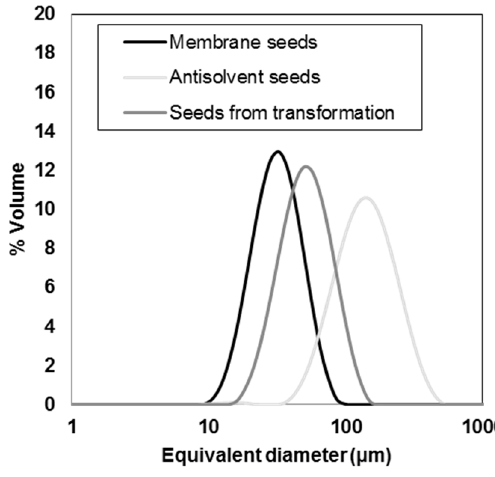
Figure 6. Crystal size distribution of the different seeds from Malvern Mastersizer.